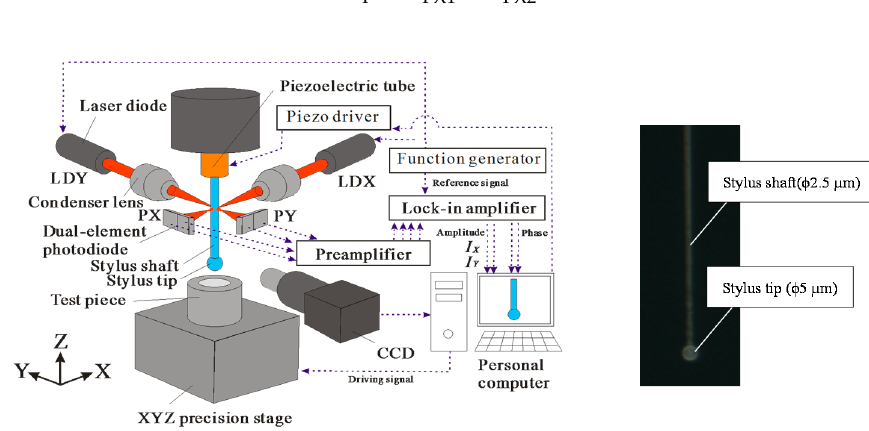
Figure 2. Measurement system using optical fiber probe.